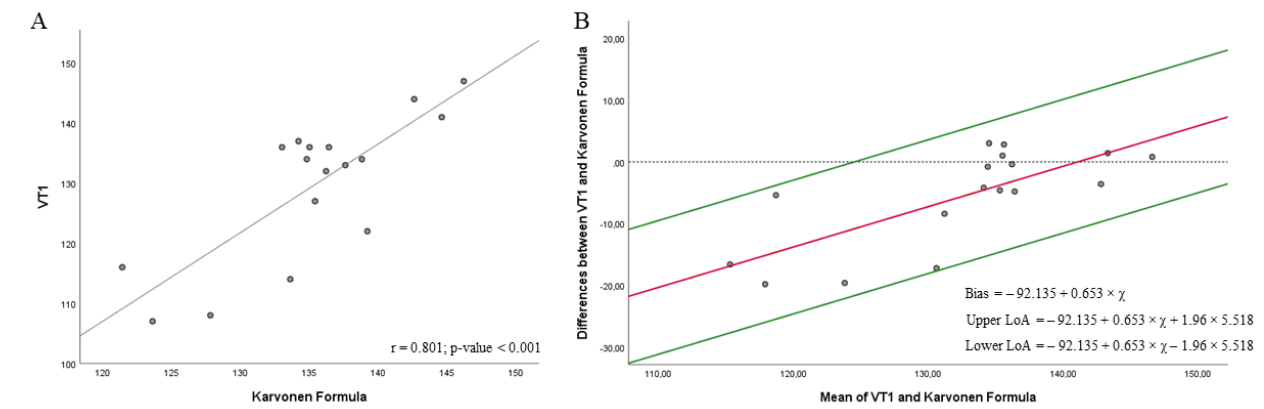
Figure 4. Correlations ( A ) and Bland–Altman plots ( B ) between the heart rate achieved in the VT1 in the cardiopulmonary exercise testing (CPET) and the Karvonen Formula at 60%.